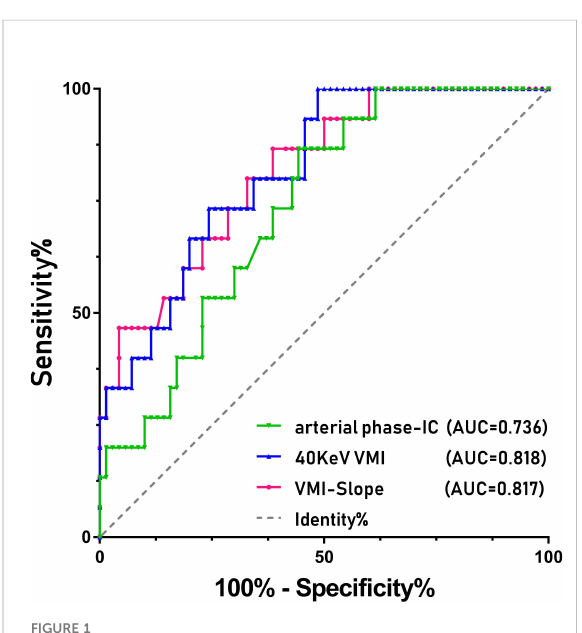
between pheochromocytoma and adrenal adenoma in patients with adrenal lesions.